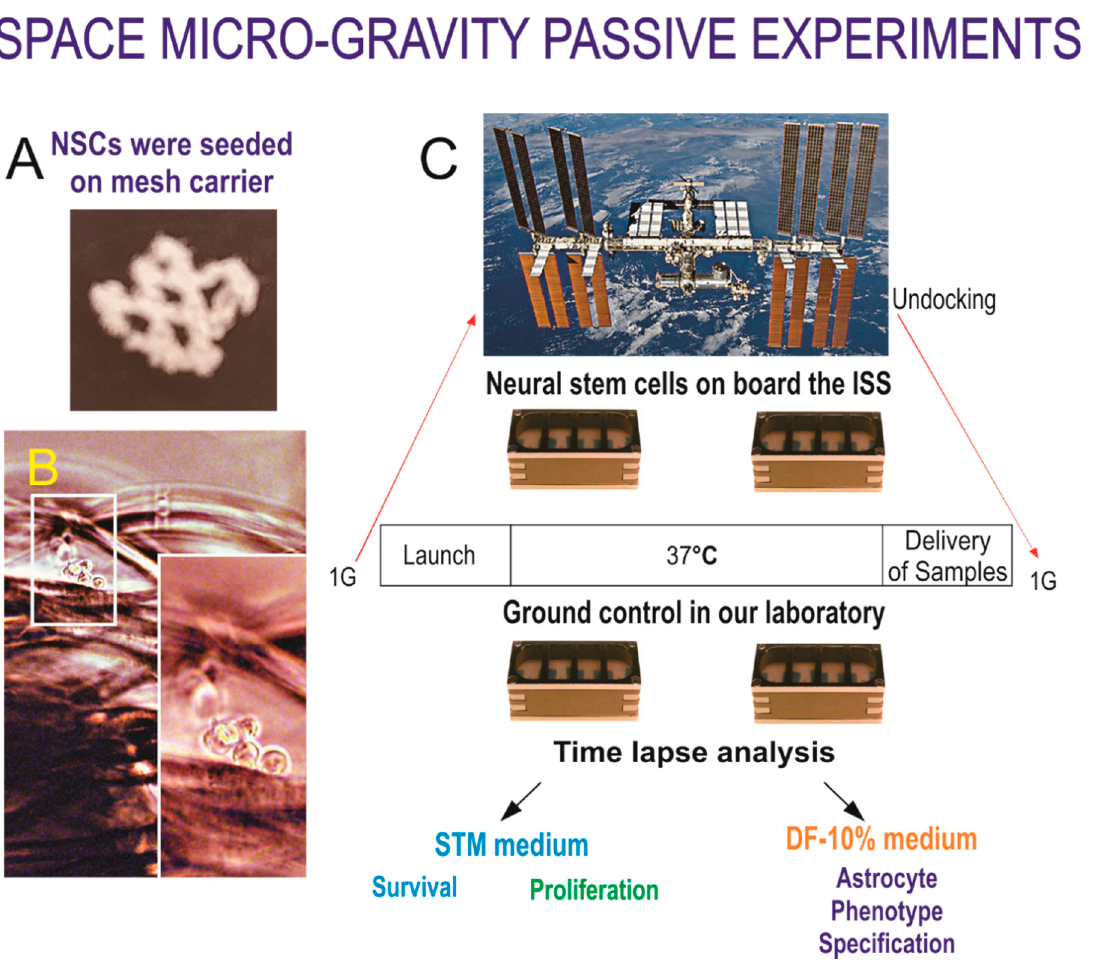
Figure 1. ( A ) A total of 0.7 × 10 6 neural stem cells (NSCs) were seeded onto the mesh carrier (proprietary composition). ( B